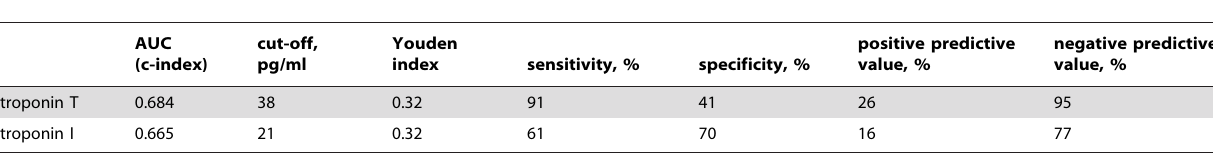
Table 4. Prognostic performance of the plasma troponin concentration in predicting death during follow-up.